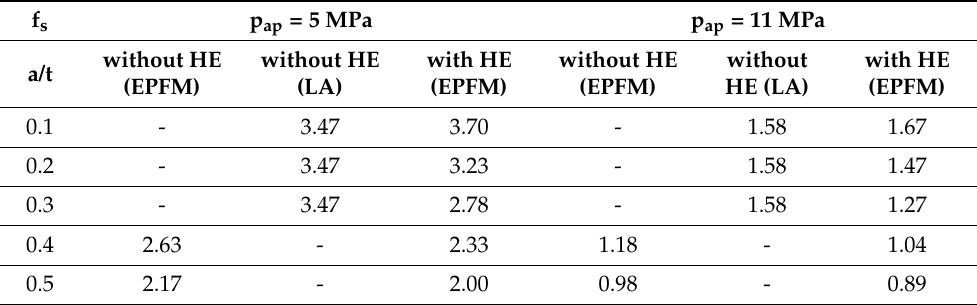
Table 8. Safety factor (f s ) values for different relative crack depth ratios (a/t = 0.1 to 0.5), with and without hydrogen and for different gas pressures ( p = 5 MPa and 11 MPa).